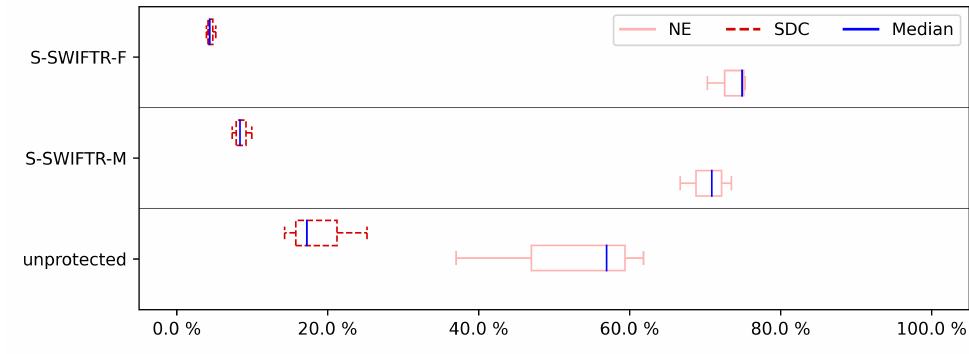
Figure 16. DFE small scale factory fault injection results for 2 registers.